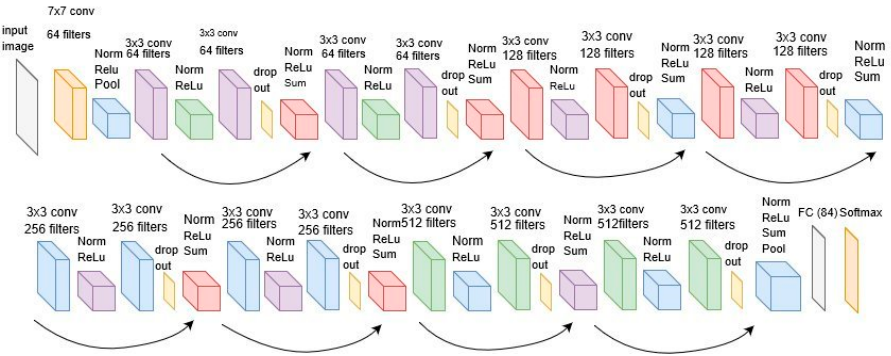
Figure 3. ResNet-18 architecture.